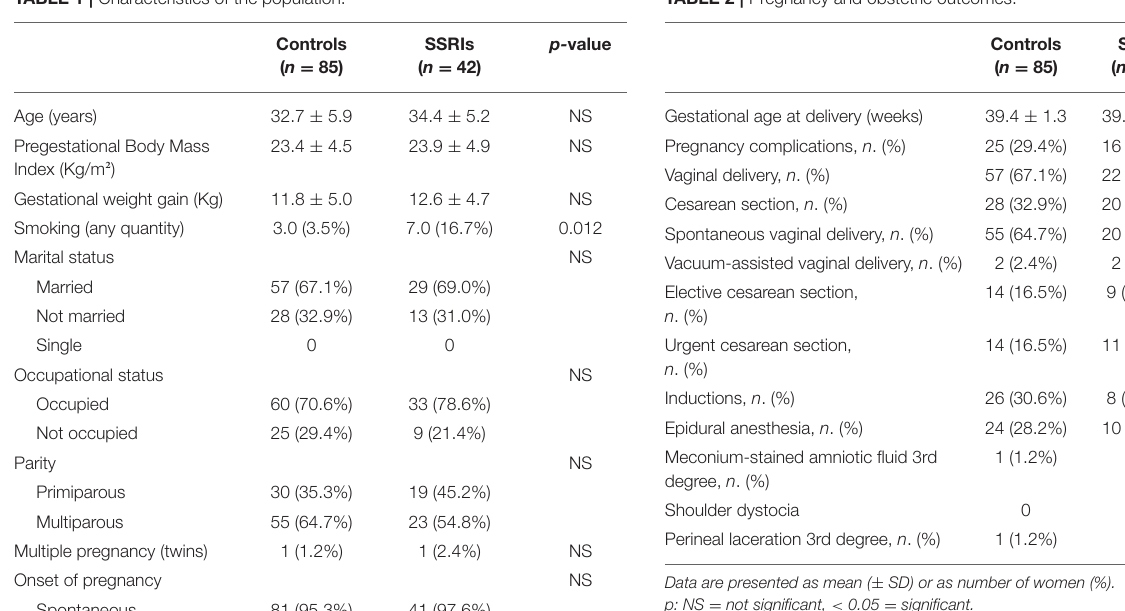
TABLE 1 | Characteristics of the population. TABLE 2 | Pregnancy and obstetric